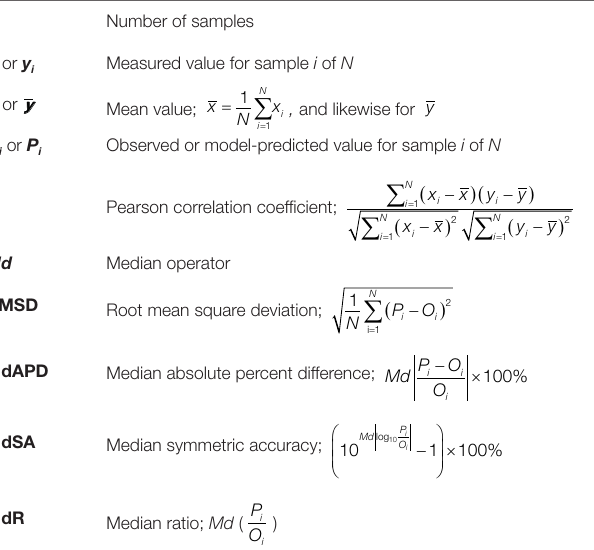
TABLE 3 | Model-assessment